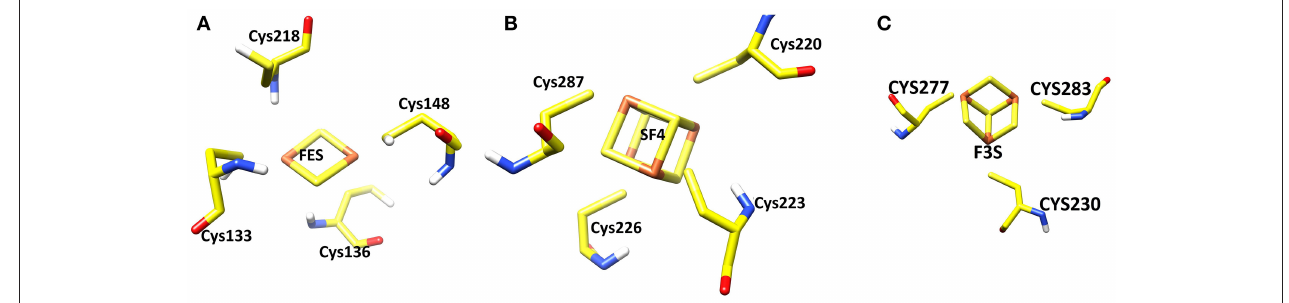
FIGURE 3 | Three iron sulfur clusters present in the model. (A) FES (B) SF4 (C) F3S